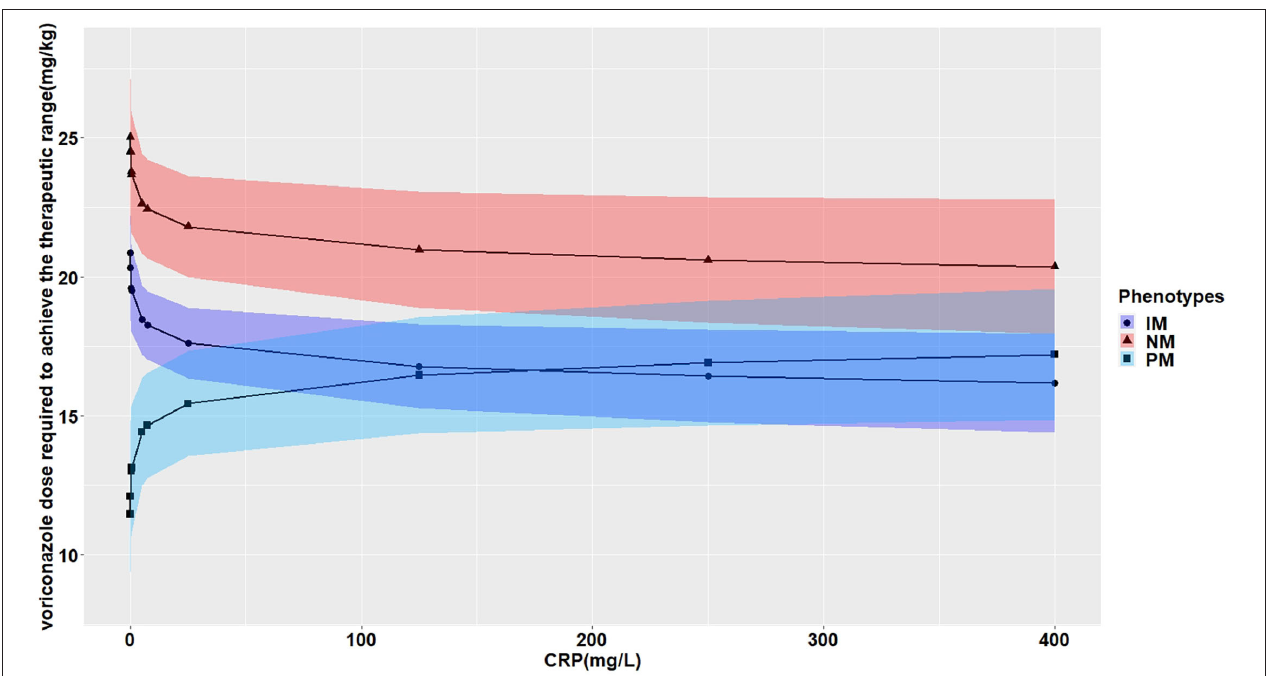
FIGURE 4 | Effects of the CRP levels on the voriconazole dose (mg/kg) required to achieve the therapeutic range according to the CYP2C19 phenotypes. The figure illustrates the predicted voriconazole dose required to achieve the therapeutic range as a function of CRP level from the multivariate generalized linear mixed-effects model. The curves with closed triangle, closed circle, and closed square represent children with normal metabolizer (NM), intermediate metabolizer (IM), and poor metabolizer (PM),